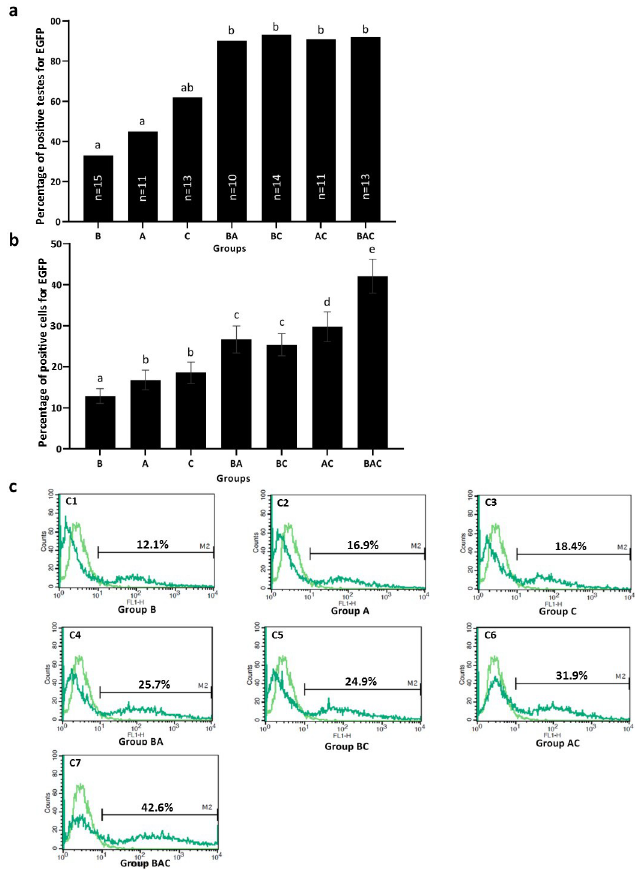
Fig 3. The testicular expression of EGFP at protein level was confirmed by flow cytometry in G 0 chickens. (a) The frequencies of EGFP positivity based on flow cytometry analysis in samples taken from the vector-injected groups. n = number of testes evaluated by flow cytometry in each group. (b) and (c) Testicular cells were harvested by trypsinization, and approximately 5 × 10 5 cells/500 μ l PBS were investigated by a BD FACS Calibur flow cytometer, using the testicular cells of non-transgenic chicks as negative controls. The relative cell number counts are plotted as a function of variable intensities of the green fluorescence from individual cells. Pale green line graph: Non-transgenic cells; dark green line graph: Transgenic cells. The percentage of total EGFP-positive cells is shown in each histogram. (b) The positive cell percentages were plotted as mean ± SEM of the data from five independent experiments. Values with different letters are significantly different ( P <